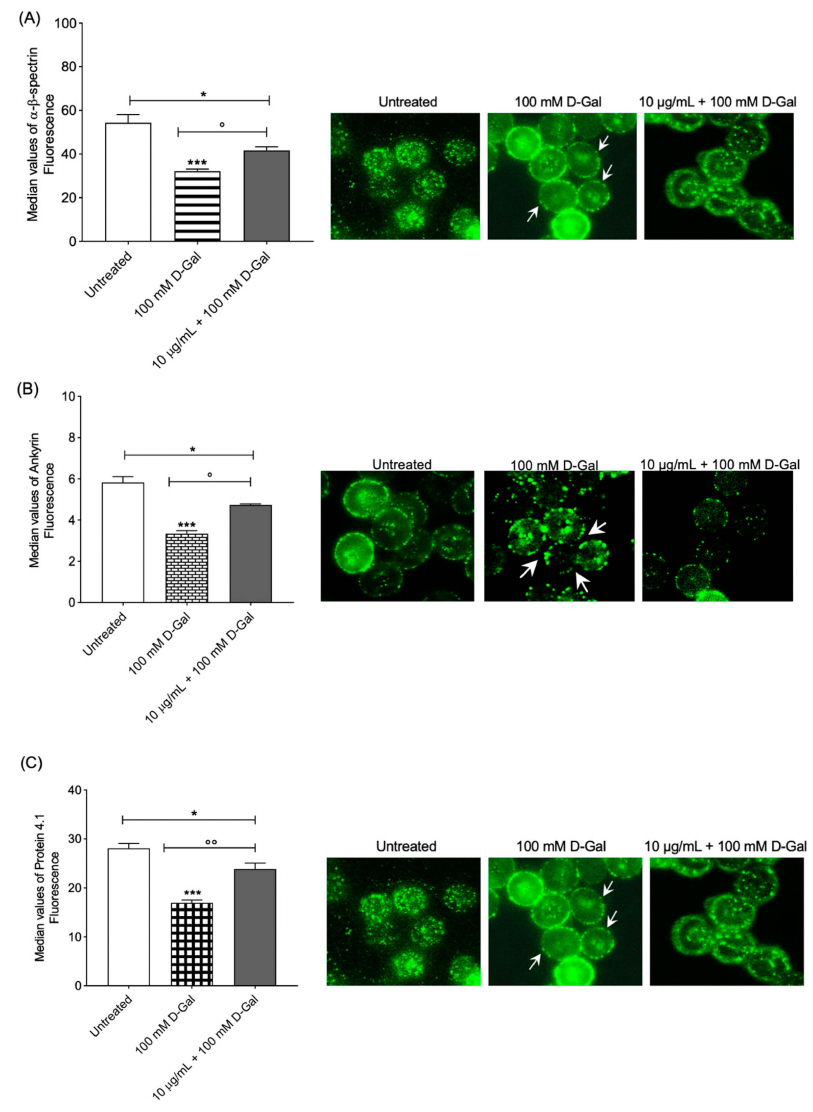
Figure 3. ( A ) Analysis using flow and static cytometry of α - and β -spectrin expression. Red blood cells were treated for 24 h with 100 mM D -Gal, with or without pre-incubation for 1 h with 10 µ g/mL Aça ì extract. Bars represent fluorescence intensity values. In panel ( A ) (right), representative images of α - and β -spectrin levels obtained using immunofluorescence are reported. Samples were observed with a 100 × objective. Note the morphological changes in 100 mM D -Gal (arrows). * p < 0.05 control; *** = p < 0.001 control; ◦ = p < 0.05 versus 100 mM D -Gal; n = 4. ( B ) Analysis using flow and static cytometry of ankyrin expression. Red blood cells were treated for 24 h with 100 mM D -Gal, with or without pre-incubation for 1 h with 10 µ g/mL Aça ì extract. Bars represent fluorescence intensity values. In panel ( B ) (right), representative images of ankyrin levels obtained using flow cytometry immunofluorescence are reported. Cell samples were observed with a 100 × objective. Note the morphological changes in 100 mM D -Gal (arrows). * = p < 0.05 left untreated (control); *** = p < 0.001 control; ◦ = p < 0.05 versus 100 mM D -Gal; n = 4. ( C ) Analysis using flow and static cytometry of protein 4.1 expression. Red blood cells were treated for 24 h with 100 mM D -Gal, with or without pre-incubation for 1 h with 10 µ g/mL Aça ì extract. Bars represent fluorescence intensity values. In panel ( C ) (right), representative images of protein 4.1 levels obtained using flow cytometry immunofluorescence are reported. Cell samples were observed with a 100 × objective. Note the morphological changes in 100 mM D -Gal (arrows). * = p < 0.05 left untreated; *** = p < 0.001 left untreated; ◦◦ = p < 0.01 versus 100 mM D -Gal; n =